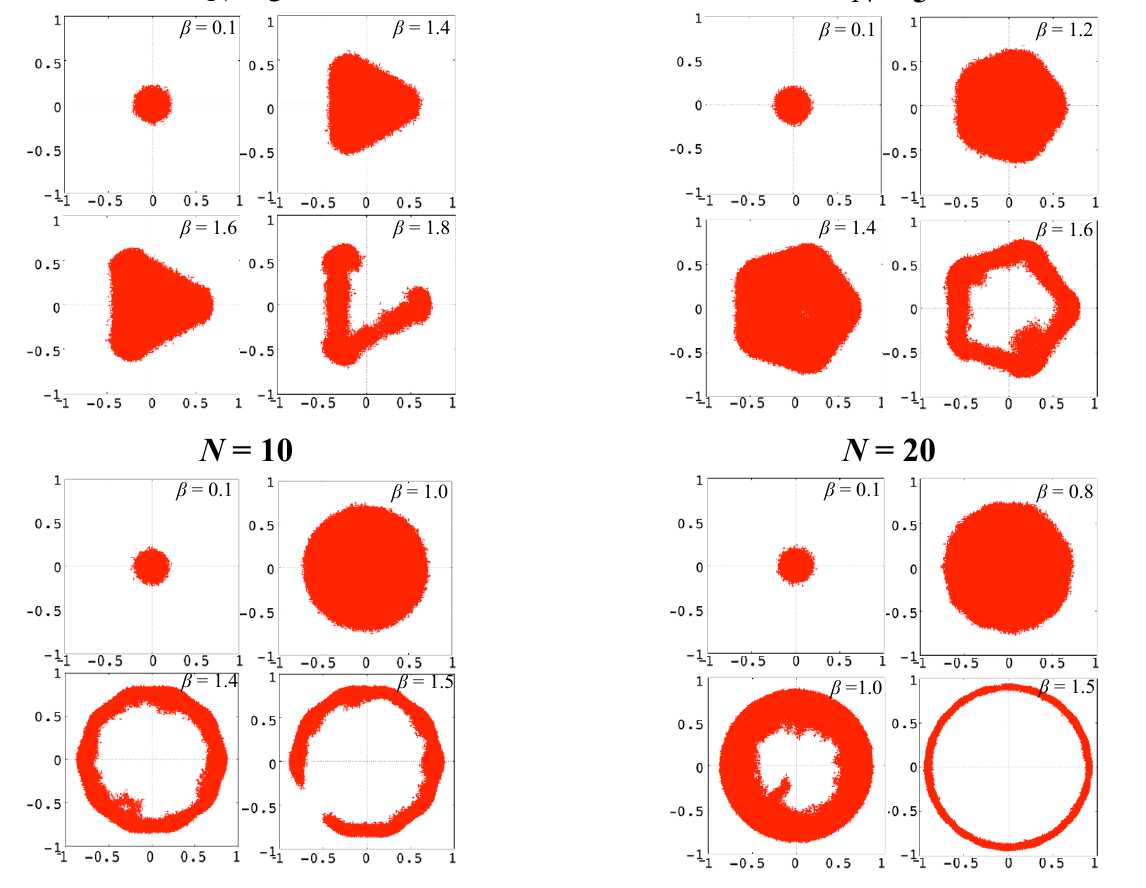
Figure 2 . Distribution plots of the Polyakov loop for N = 3 ; 5 ; 10 ; 20 with ( N s ; N (cid:28) ) = (200 ; 8) with Z N -TBC. Regular N -sided polygon shapes appear at high (cid:12)